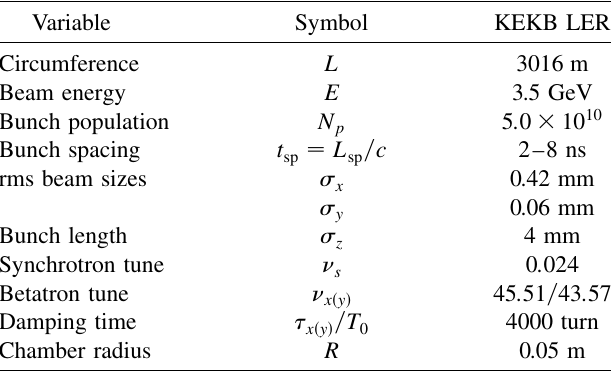
TABLE I. Basic parameters of the KEKB